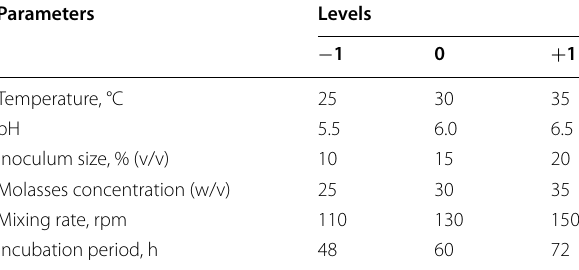
Table 3 Parameters and level of the experiment design